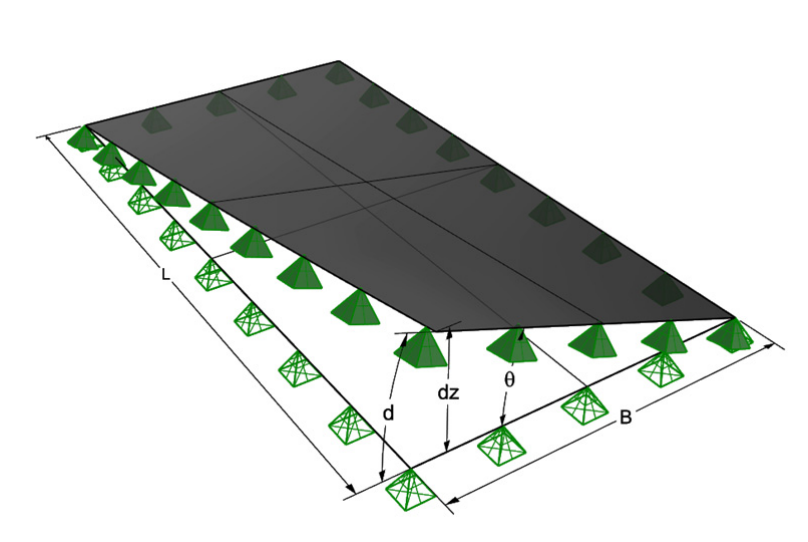
Fig. 1 Edge Support Condition and Variable Definitions for Twist Optimization